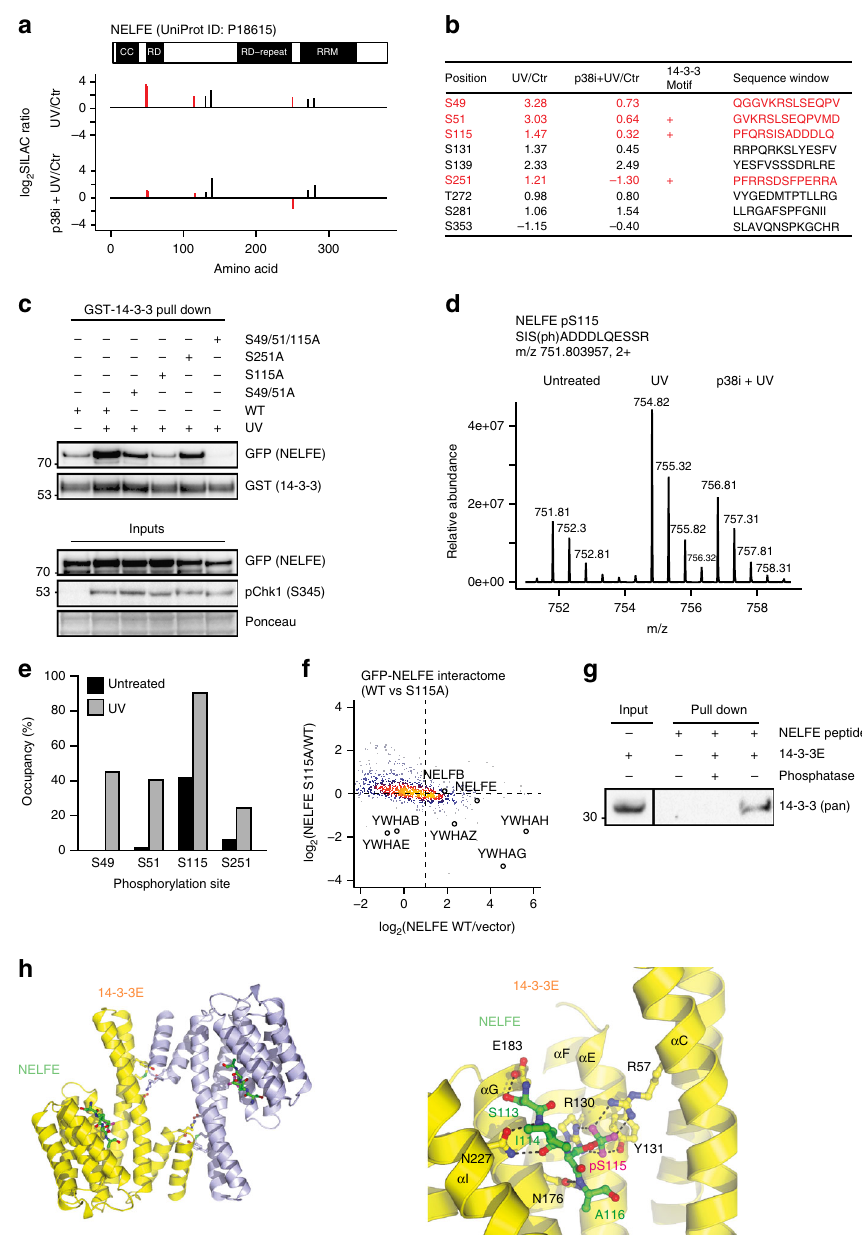
Fig. 5 NELFE phosphorylation on S115 is required for the interaction with 14-3-3. a Schematic representation of NELFE domain organization and phosphorylation sites that were identi fi ed by phosphoproteomics. The SILAC ratios quanti fi ed for phosphorylation sites on NELFE after UV light and p38 inhibition are indicated. UV-light-induced, p38-dependent phosphorylation sites are labeled in red. b The table shows all phosphorylation sites identi fi ed on NELFE by phosphoproteomics. The position, SILAC ratios, 14-3-3 binding prediction and sequence window are indicated. UV-light-induced, p38-dependent phosphorylation sites are labeled in red. c Serine 115 phosphorylation is required for the interaction of NELFE and 14-3-3. U2OS cells expressing GFP-tagged wild-type NELFE or NELFE serine-to-alanine mutants were irradiated with UV light. Protein extracts were incubated with GST-14-3-3 and enriched proteins were resolved on SDS-PAGE. d Mass spectrometric parent ion scan of the peptide SISADDDLQESSR corresponding to S115 in NELFE. The SILAC triplet shows the relative abundance and mass to charge (m/z) of the phosphorylated peptide in mock-treated cells and cells irradiated with UV light without or with pretreatment with the p38 inhibitor. e Absolute occupancy of serine 49, 51, 115, and 251 phosphorylation in NELFE in undamaged cells and after UV light was determined by MS. f NELFE S115A mutant does not bind to 14-3-3. SILAC-labeled cells overexpressing GFP-tagged wild-type NELFE or NELFE S115A mutant were irradiated with UV light. UV-light-irradiated U2OS cells overexpressing GFP alone were used as control. Cells were lysed and protein extracts were incubated with GFP Trap agarose. The scatter plot shows the logarithmized SILAC ratios of quanti fi ed proteins. The color-coding indicates the density. g Recombinant 14-3-3 binds to phosphorylated NELFE peptide. Biotinylated phosphorylated NELFE peptide corresponding to serine 115 was bound to NeutrAvidin agarose. Phosphorylated and dephosphorylated peptide were incubated with puri fi ed 14-3-3. h Structure of 14-3-3 epsilon in complex with NELFE phosphorylated peptide QPFQRSI(p)SADDDLQE. Structure of the 14-3-3 epsilon in cartoon representation (Yellow and Cyan) and NELFE phosphorylated peptide in ball and stick model (Green). The inset on the right shows the 14-3-3 epsilon – NELFE phosphorylated peptide